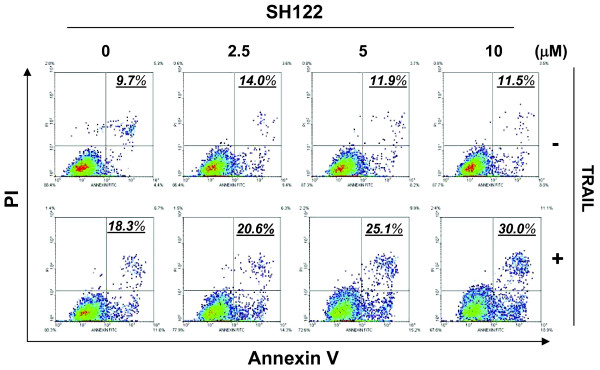
SH122 enhanced TRAIL-induced apoptosis. DU145 cells were seeded into 6-well plates at a concentration of 2 × 105/ml, and exposed by 2.5, 5 and 10 μM of SH122, with or without TRAIL (50 ng/ml). Eighteen hours after incubation, cells were harvested and processed for Annexin V-FITC and PI staining by flow cytometry. Numbers represented total apoptosis (Annexin V positive cell population). Data represented one of three independent experiments.